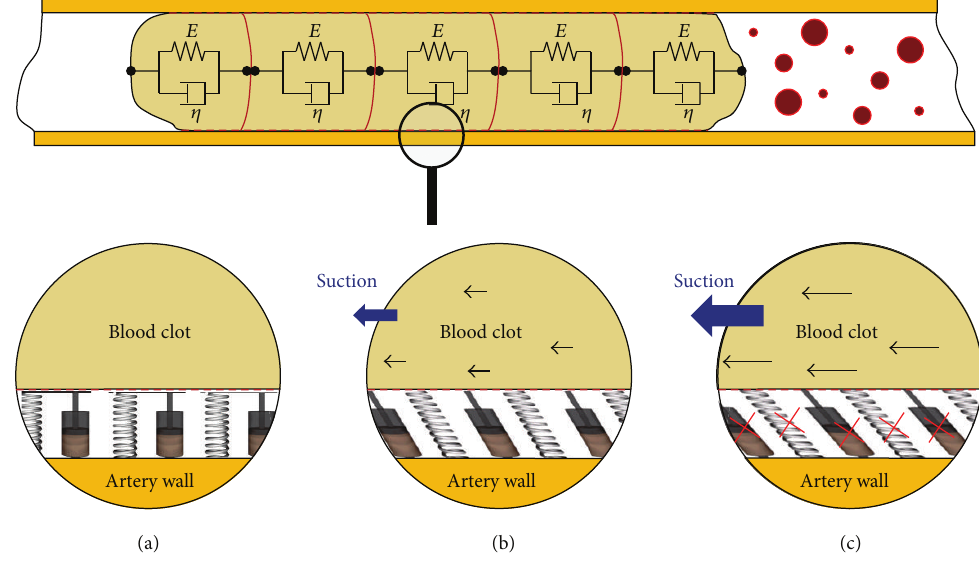
Figure 6: Artery wall adherence based on individual spring-damper systems. (a) No force. (b) Suction force lower than adherence force. (c) Suction force higher than adherence force.